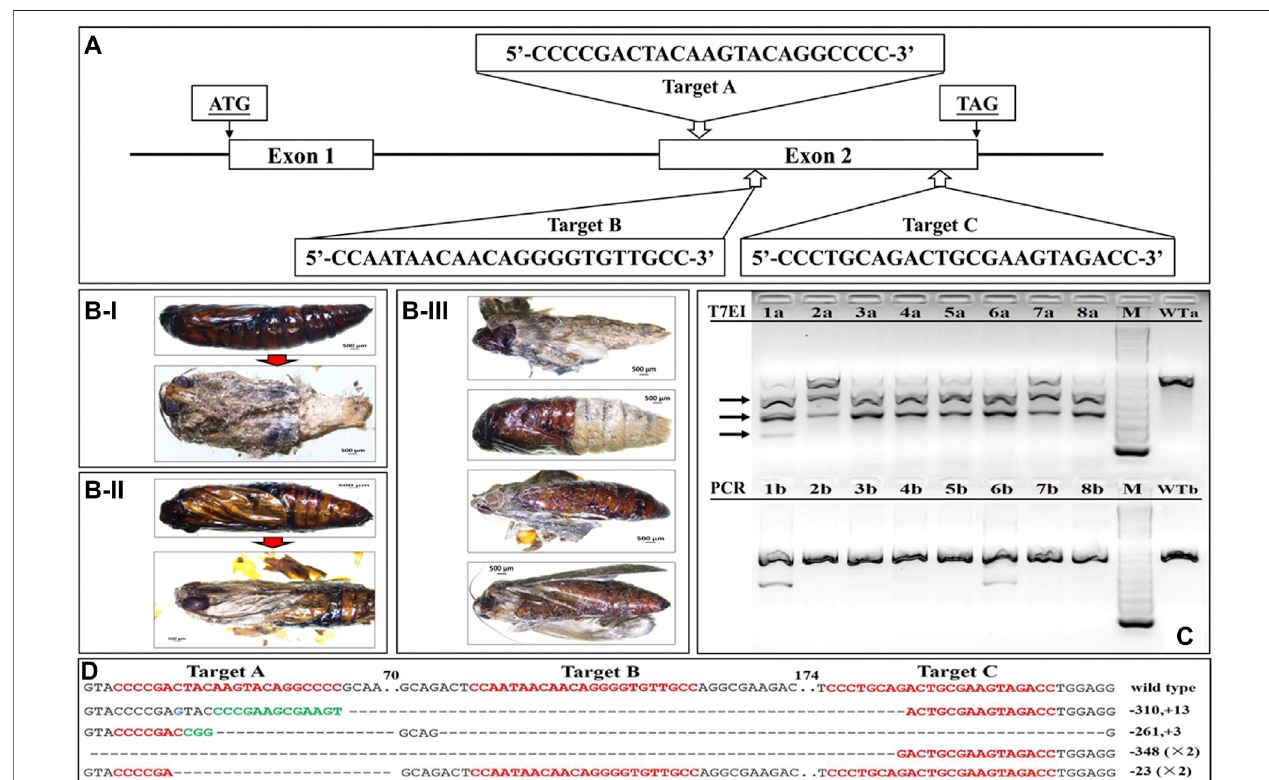
FIGURE 3 | Site-speci fi c mutagenesis and phenotypes of SfSoxC knockout in S. frugiperda . Fresh eggs (laid within 1 h) were lined on a microscopic slide, and a mixture containing 300 ng/ μ L Cas9 protein and 100 ng/ μ L of each sgRNA was injected into eggs that were less than 2 h old. Three sgRNAs were co-injected together with the same concentration. Injected eggs were kept in a sterile petri dish at 27 ± 1 ° C until hatching. (A) Schema of sgRNA target site in exon2 of SfSoxC gene. Three targetsites(TargetA,TargetB,TargetC)wereselectedforgenomeediting.ATGisthetranslationinitiationcodonandTAGisthetranslationterminationcodon. (B) Thephenotypesof SfSoxC knockout.Insidethepupa,compoundeyes,antennae,mouthparts,andappendageswereclearlyseenbutthewingswerepoorlydeveloped (B-I and B-II) . The pupal shell was not shed from body completely (B-III) . (C) The mutagenesis in SfSoxC gene con fi rmed by T7EI assay. Genomic DNA was isolated and PCR-ampli fi ed from 8 randomly selected adults (1 – 8) that showed SfSoxC gene knockout phenotype. The ampli fi ed products were run on agarose gels with (T7EI, 1a-8a) or without (PCR, 1b-8b) T7EI endonuclease digestion. The arrows on the left show the digested products. The DNA marker was 1 kb ladder (M). The wildtype controlsareshown(WTaandWTb). (D) Mutantallelesidenti fi edbyTAclonesequencing.Wild-typesequencesareshownatthetopwiththe3targetsitesmarkedbyred letters. Deletions are shown as dashes and insertions are shown as green letters. The net change in length is shown at the right of each sequence (+: insertion; −